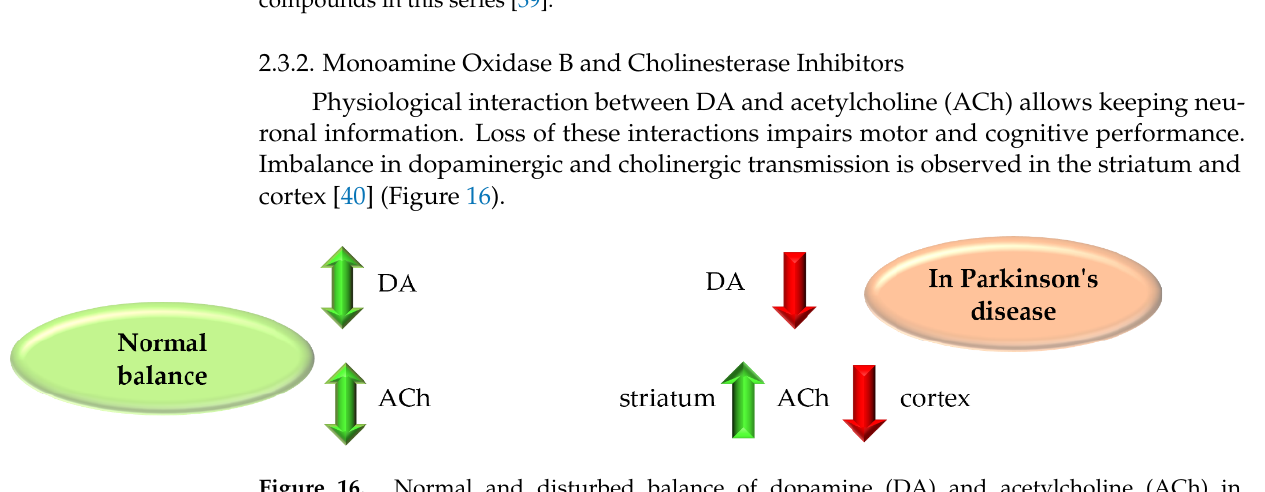
Figure 15. Dual COMT and MAO B inhibitors synthesised by Hitge et al. and the most potent com- pounds in this series [39].